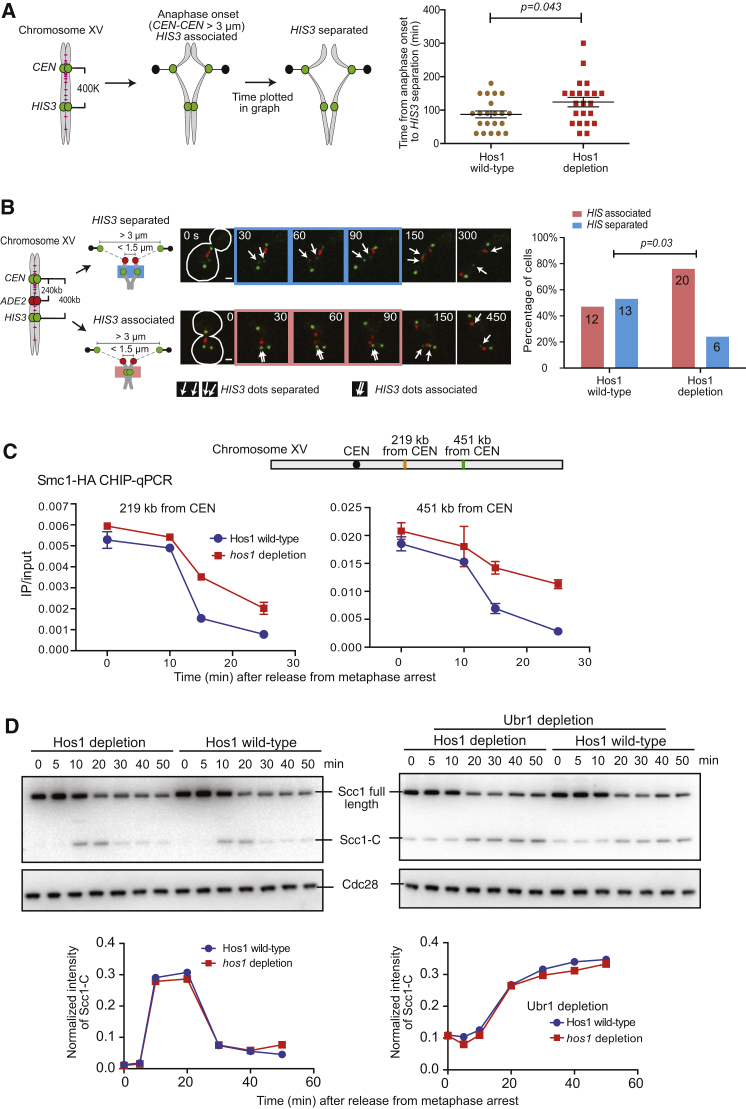
Hos1 Promotes Dissolution of Sister Chromatid Cohesion and Removal of Cohesins, without Affecting Scc1 Cleavage, during Early Anaphase(A and B) Separation of sister HIS3 loci after anaphase onset is delayed in Hos1-depleted cells. HOS1 wild-type (T11710) and hos1-aid (T11713) cells with TetR-GFP, 3xCFP-LacI (Lac repressor fused with three tandem copies of CFP), tetOs at CEN and HIS3 loci, and lacOs at ADE2 locus were treated as in Figure 1C. Anaphase onset was defined as in Figure 1D. In (A), images of GFP-labeled loci (CEN, HIS3) were collected every 30 s for 45 min from 80 min after release from G1 arrest (A, diagram). The timing of sister HIS3 separation in individual cells was plotted (A, graph). The bars in the graph show mean and SEM. In (B), images of GFP- and CFP-labeled loci (CEN, ADE2, and HIS3) were collected. Representative time-lapse images in (B) show separation and segregation of CEN, ADE2, and HIS3 loci (scale bar, 1 μm). We scored separation and non-separation of sister HIS3 after anaphase onset but before the spindle force is applied (sister ADE2 distance < 1.5 μm) (B, graph; sample numbers on bars). p values were obtained by t test (A) and Fisher’s exact test (B).(C) Removal of cohesins is delayed during early anaphase in Hos1-depleted cells. HOS1 wild-type (T11875) and hos1-aid (T11874) cells with SMC1-HA, SPC42-mCherry, MYO1-mCherry, PGAL-CDC20 (CDC20 expressed from GAL1-10 promoter), and cdc15-as were released from G1 arrest to YPA medium with raffinose (to deplete Cdc20 for metaphase arrest). After 2.5 hr, galactose was added (defined as time 0) to release cells from metaphase arrest (by re-expressing CDC20). NAA and 1NM-PP1 were added for the last 1 hr during metaphase arrest, and after release from the arrest, to deplete Hos1-aid and to prevent completion of cytokinesis (by inhibiting Cdc15-as kinase), respectively. Cells were harvested at 10, 15, and 25 min and analyzed for Smc1-HA association at 219 and 451 kb from CEN15 on chromosome XV (cohesin enrichment sites; Natsume et al., 2013) using ChIP-qPCR. The IP:input ratio in CHIP is plotted in graphs, where error bars show SD (n = 3).(D) The efficiency of Scc1 cleavage was not affected by Hos1 depletion. HOS1 wild-type (T11914), hos1-aid (T11912), HOS1 wild-type ubr1-aid (T12726), and hos1-aid ubr1-aid (T12724) cells with SCC1-HA, SPC42-mCherry, MYO1-mCherry, PGAL-CDC20, and cdc15-as were treated as in (C). Time 0 is defined as in (C). Samples were taken at indicated time points and analyzed by western blotting using anti-HA (top) and anti-Cdc28 (bottom, loading control) antibody. The amount of the C-terminal Scc1 cleavage product (Scc1-C) was quantified, normalized to that of Cdc28, and plotted in graphs.See also Figure S2.